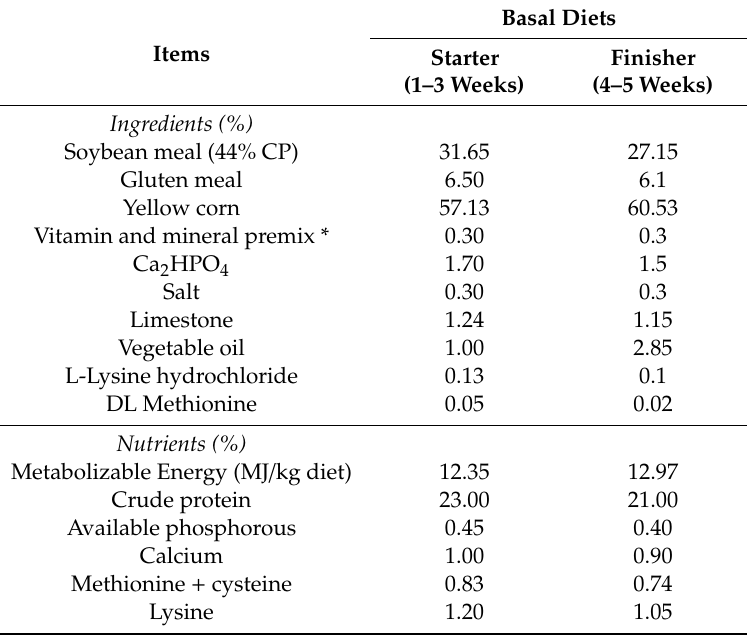
Table 1. Composition of the basal diets (as